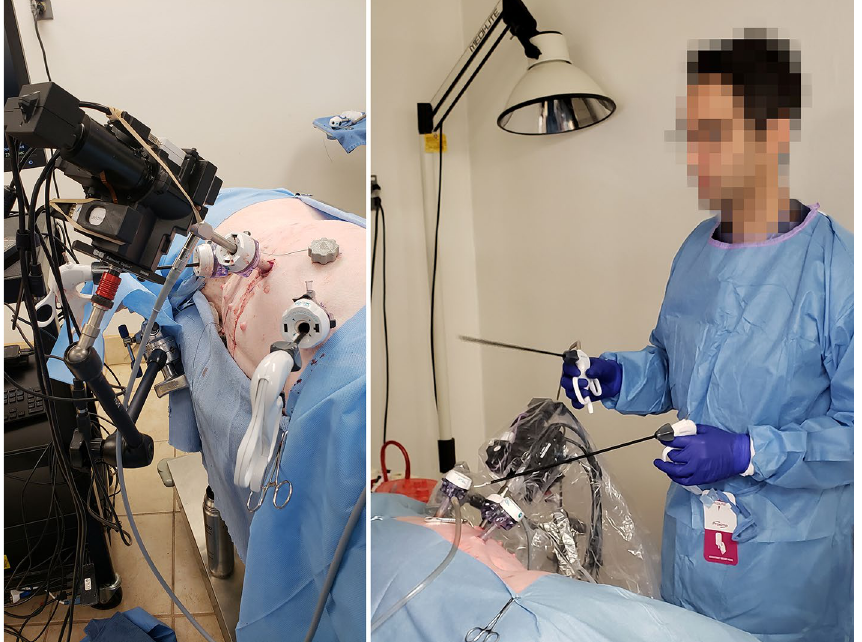
Figure 5. Photographs of the MRFL prototype being used for porcine surgery. The MRFL is mounted to the surgical table and remains stationary throughout the surgery (left). Thus, a surgeon may operate without need of an assistant in the immediate vicinity to hold the camera (right).